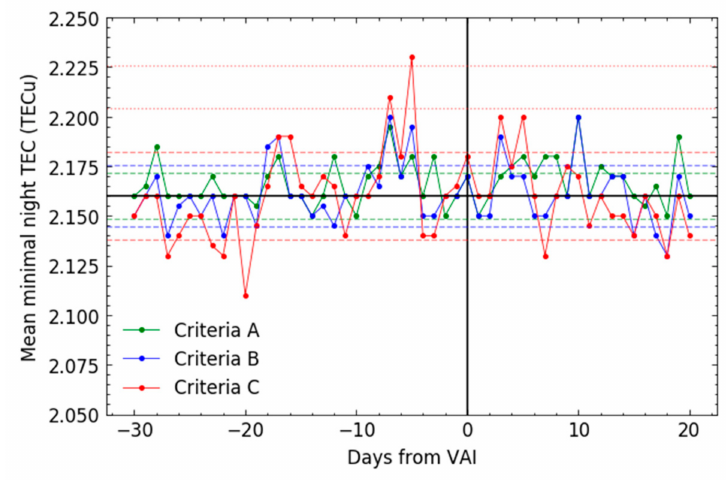
Figure 9. Median values of minimum night TEC at IGS Noto. Before the observed peak, TEC oscillations (enhancements and depletions during several days before the VAI) at IGS Noto can be also seen. Such a pattern seems to cease with VAI. Applying the FFT method, two prominent peaks were found (Figure 10). The largest oscillation is found to have a period of 12.5 days (half-period of 6.25 days), with the second largest oscillation of 8.5 days (half-period of 4.25 days). This corresponds to the two most prominent peaks in the frequency-domain data. The observed peaks are consistent within all criteria.